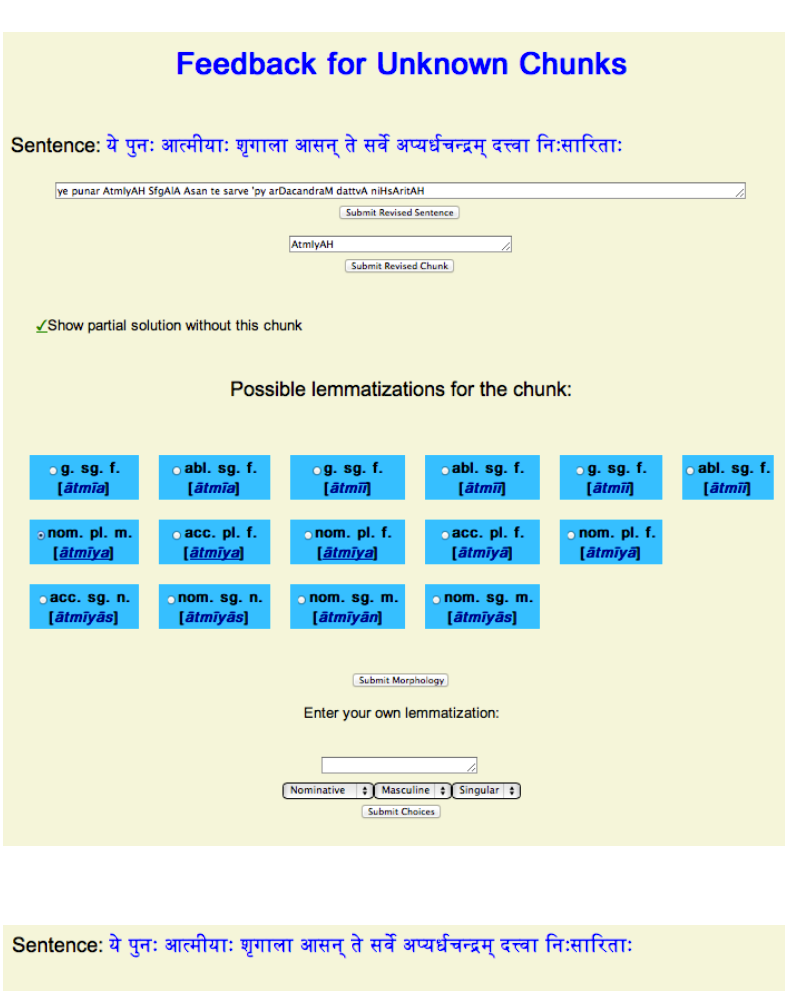
Figure 12: Options provided to the annotator for the unanalysed chunk ātmīyāḥ